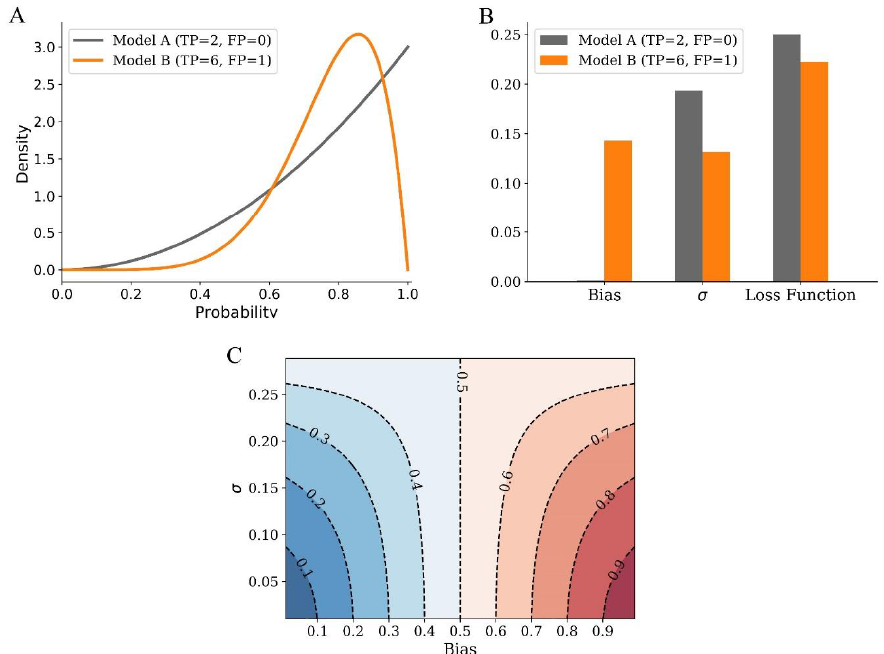
Figure 1. Bias and variance analysis of LBS (Local Beta Screening). ( A ) Probability density of screening model A (TP = 2 and FP = 0) and B (TP = 6 and FP = 1). ( B ) Comparison of screening model A and B